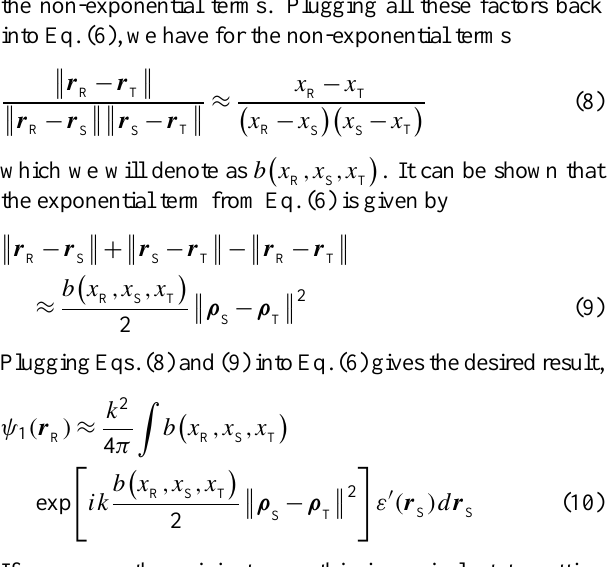
Turbulence patch